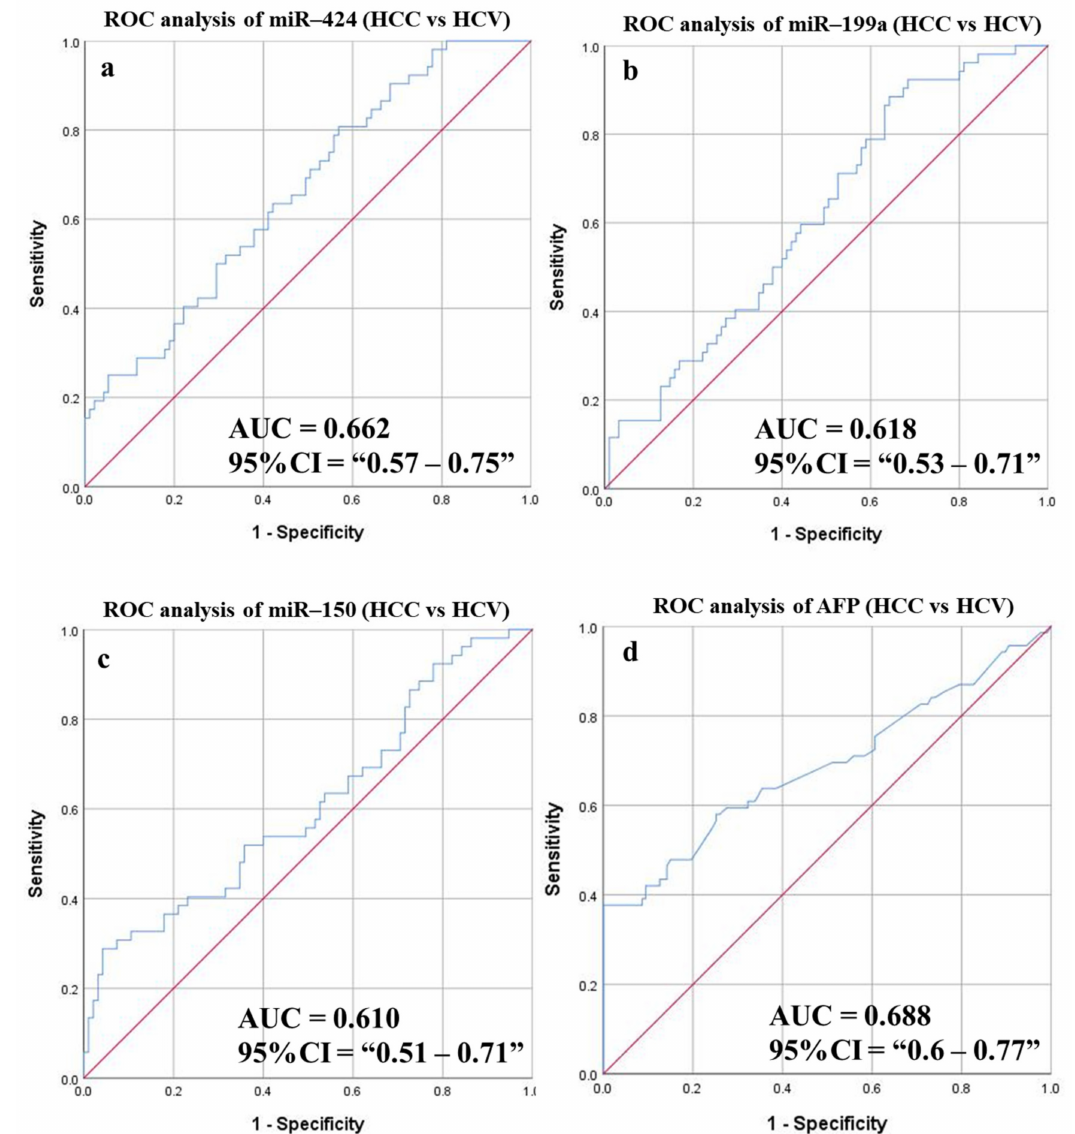
Figure 11. ROC curves and AUC for DE-miRNAs compared to AFP to differentiate between HCC and HCV patients. The diagnostic potential and AUC of three DE-miRNAs [( a ) miR-424 ( b ) miR-199a and ( c ) miR-150], in addition to ( d ) AFP were calculated. (AFP: Alpha-fetoprotein, DE: Differentially expressed, HCC: Hepatocellular carcinoma, ROC: Receiver operating